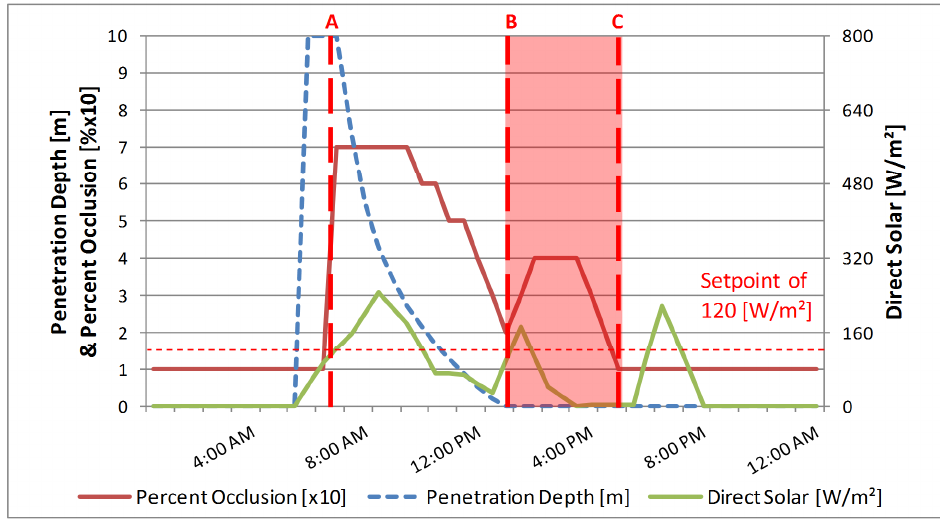
Figure 8. Hourly typical error of blind control algorithm on 26 April (Blindswitch